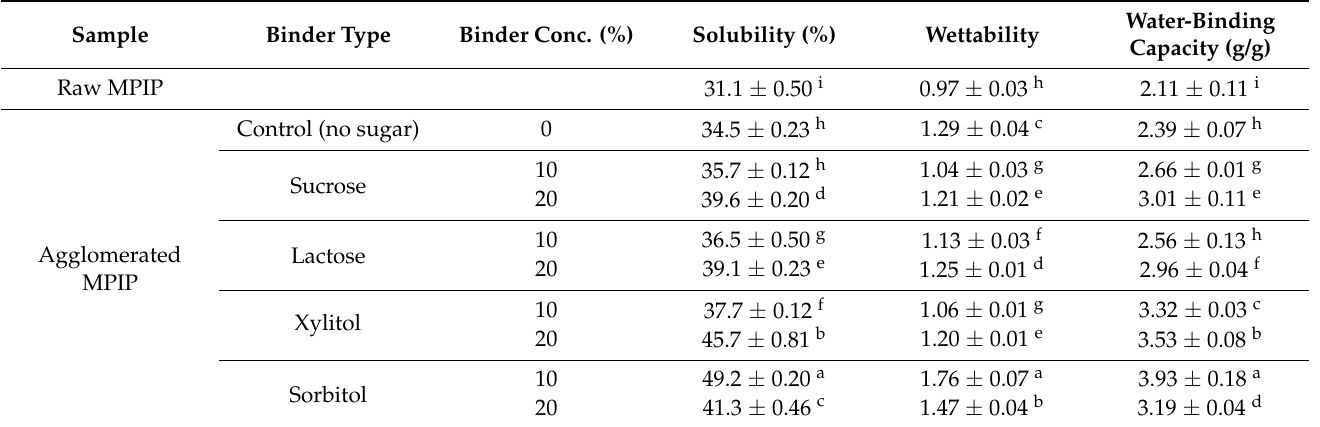
Table 3. Water-holding properties of raw and agglomerated MPIPs with various sugar binders at different